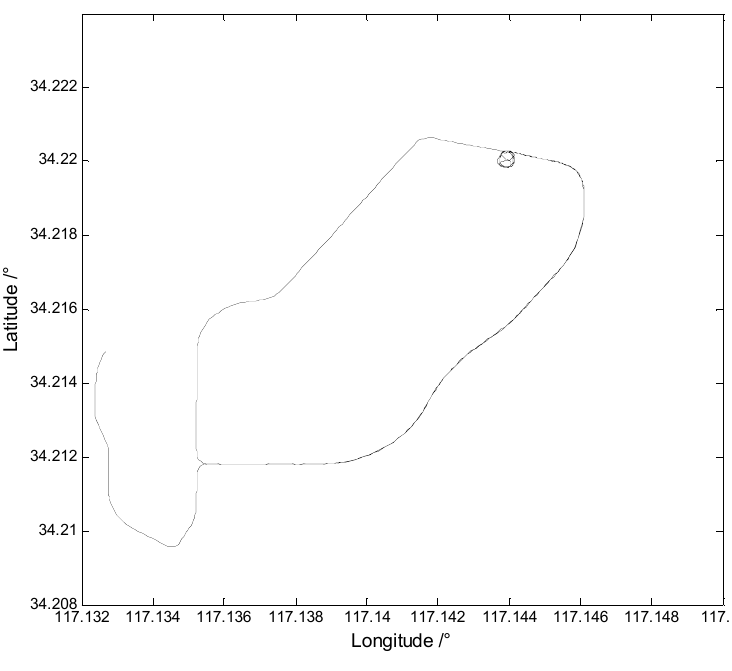
Figure 1. The motion trajectory of the land vehicle.